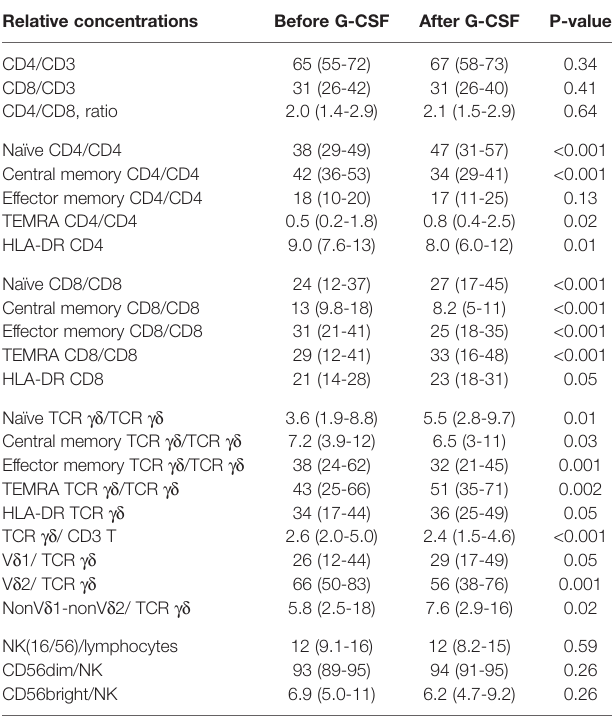
TABLE 2 | Relative concentrations of T and NK cell subsets before and after G- CSF stimulation in peripheral blood of healthy donors, n=49. Relative concentrations Before G-CSF After G-CSF